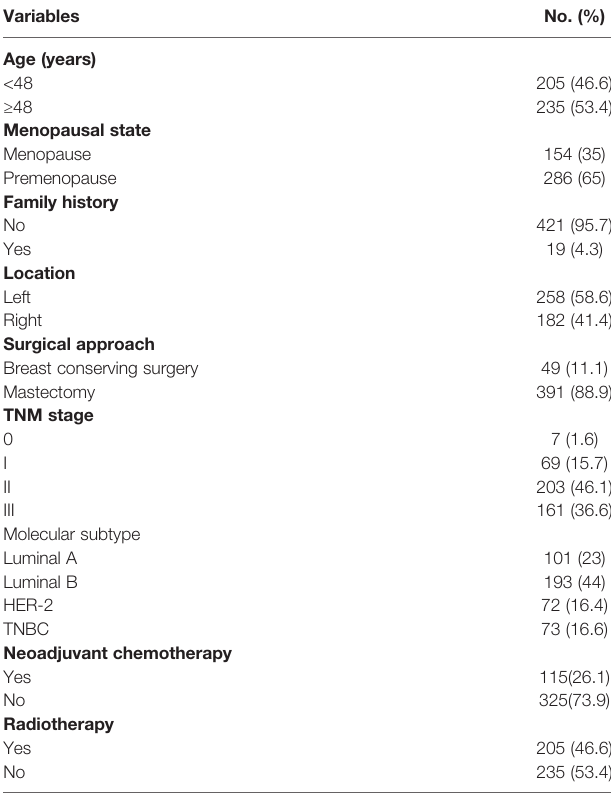
TABLE 1 | Baseline characteristics of the enrolled patients.